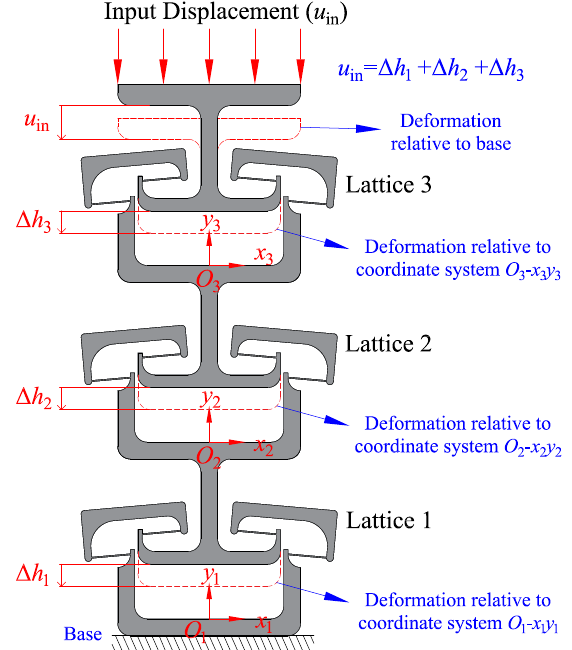
Figure 9. The parameters defined to describe the process of